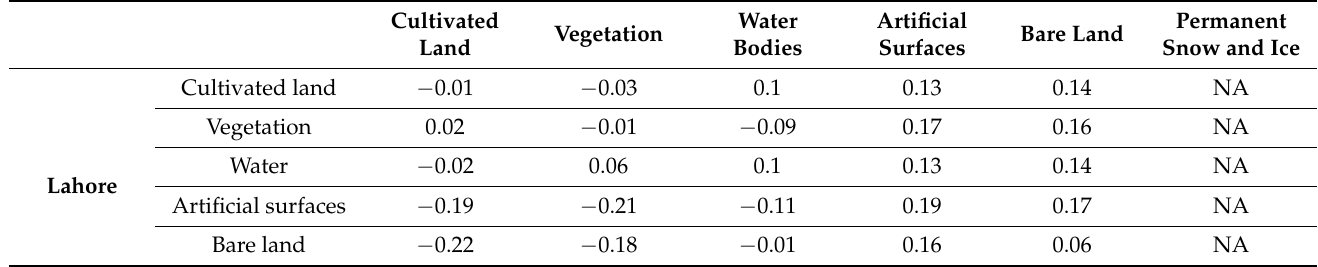
Figure 10. Sensitivity analysis between LST and carbon emission.